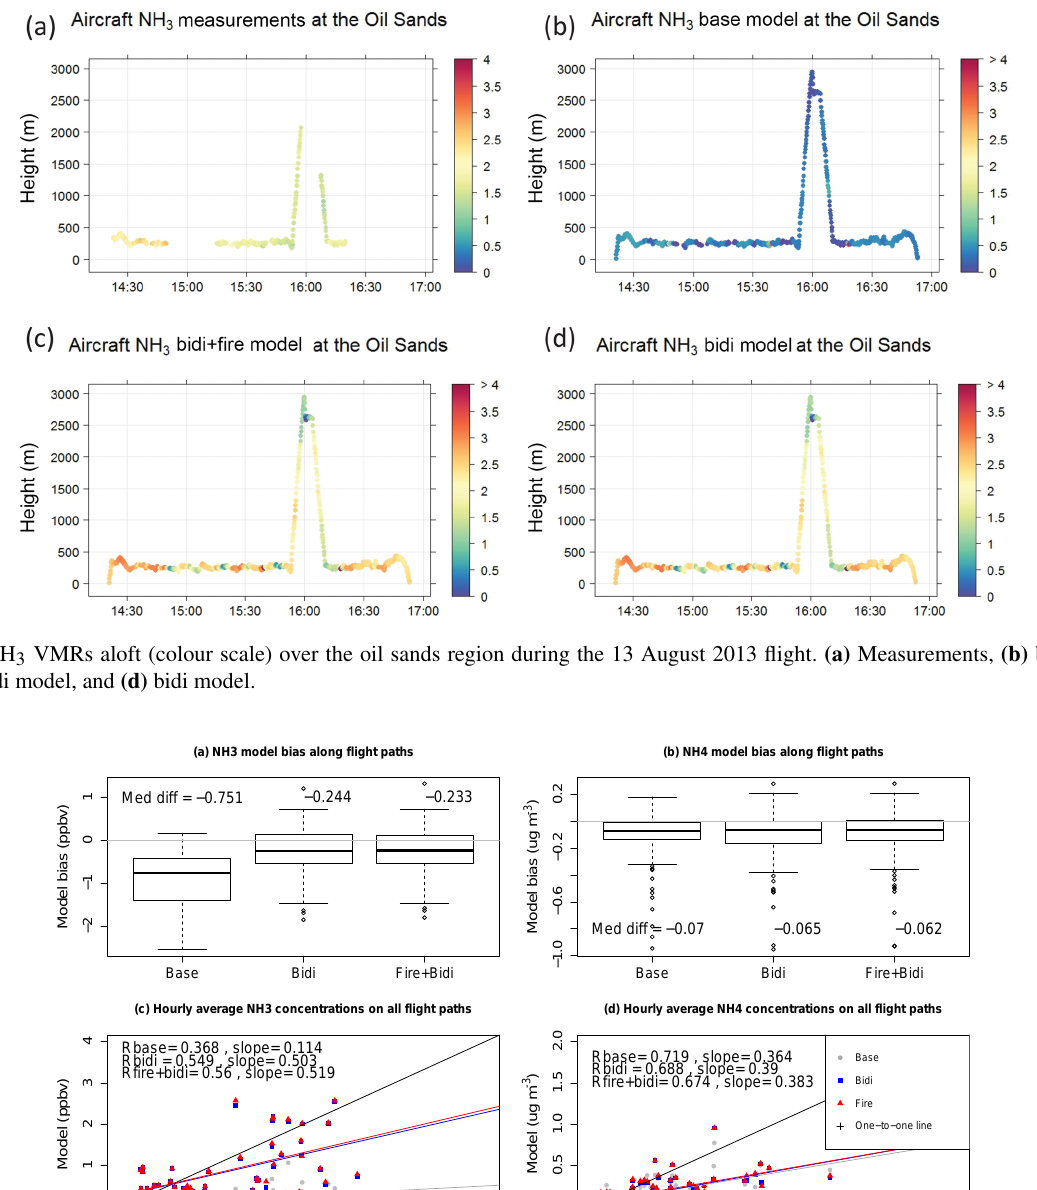
concentrations aloft. Base model is in grey, bidirectional flux 4